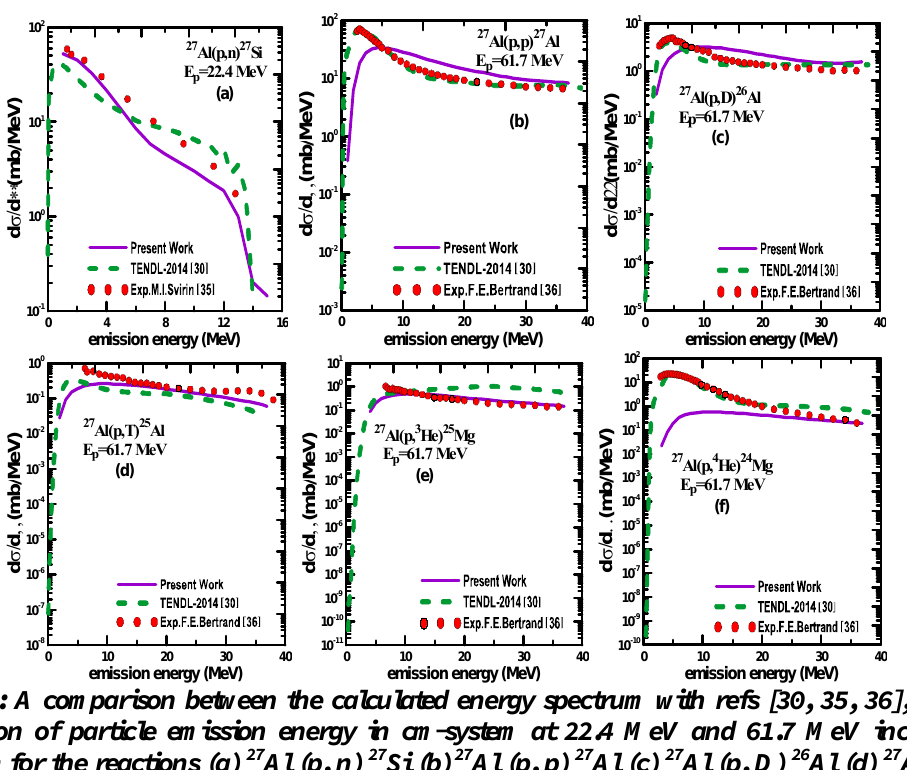
Fig. 3: A comparison between the calculated energy spectrum with refs [30, 35, 36], as a function of particle emission energy in cm-system at 22.4 MeV and 61.7 MeV incident proton for the reactions (a) 27 Al (p, n) 27 Si (b) 27 Al (p, p) 27 Al (c) 27 Al (p, D) 26 Al (d) 27 Al (p, T) 25 Al (e) 27 Al (p, 3 He) 25 Mg (f) 27 Al (p, 4 He) 24